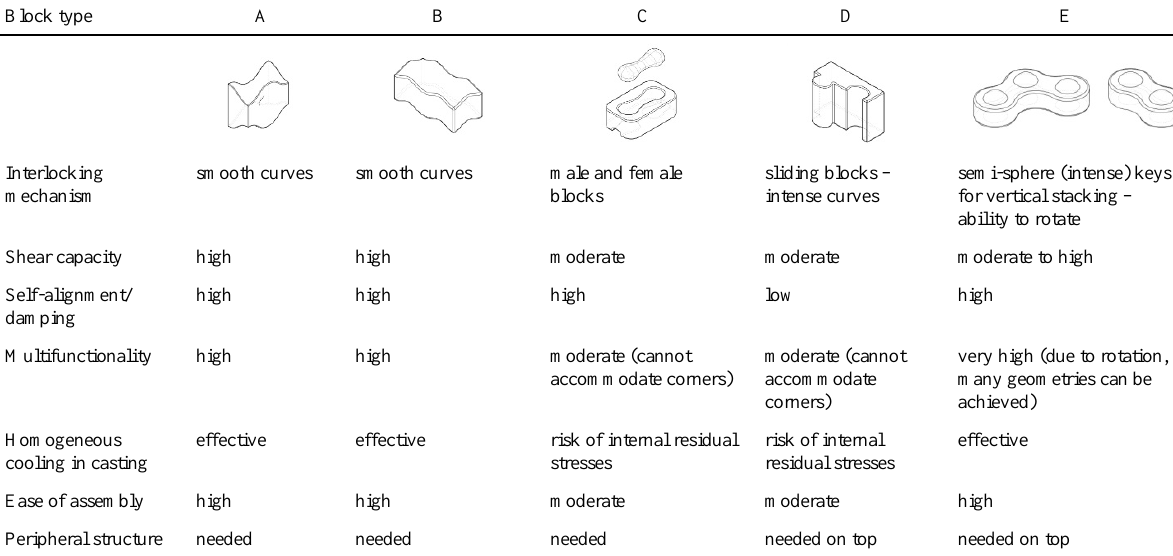
Table 2: Assessment of the different interlocking block types in terms of design